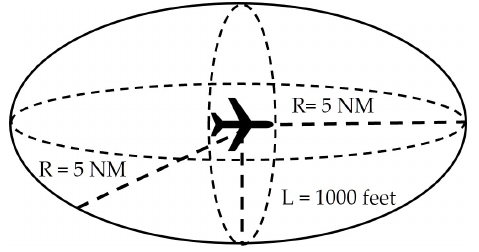
Figure 5. Ellipsoidal flight protection zone.